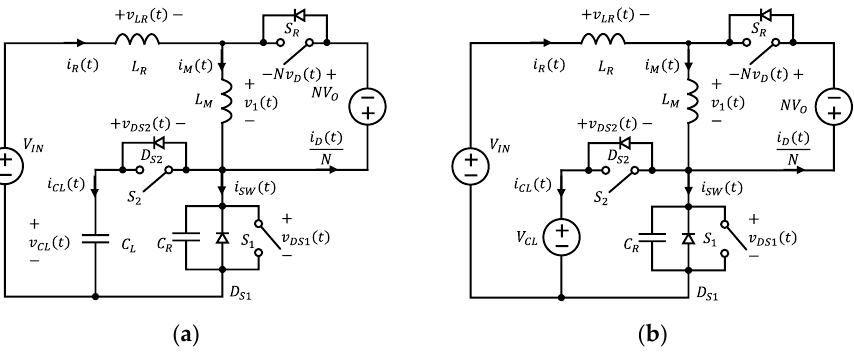
Figure 4. Equivalent circuit of QR flyback converter with self-driving active snubber: ( a ) equivalent circuit of QR flyback converter with diode rectifier; ( b ) equivalent circuit of QR flyback converter with synchronous rectifier.